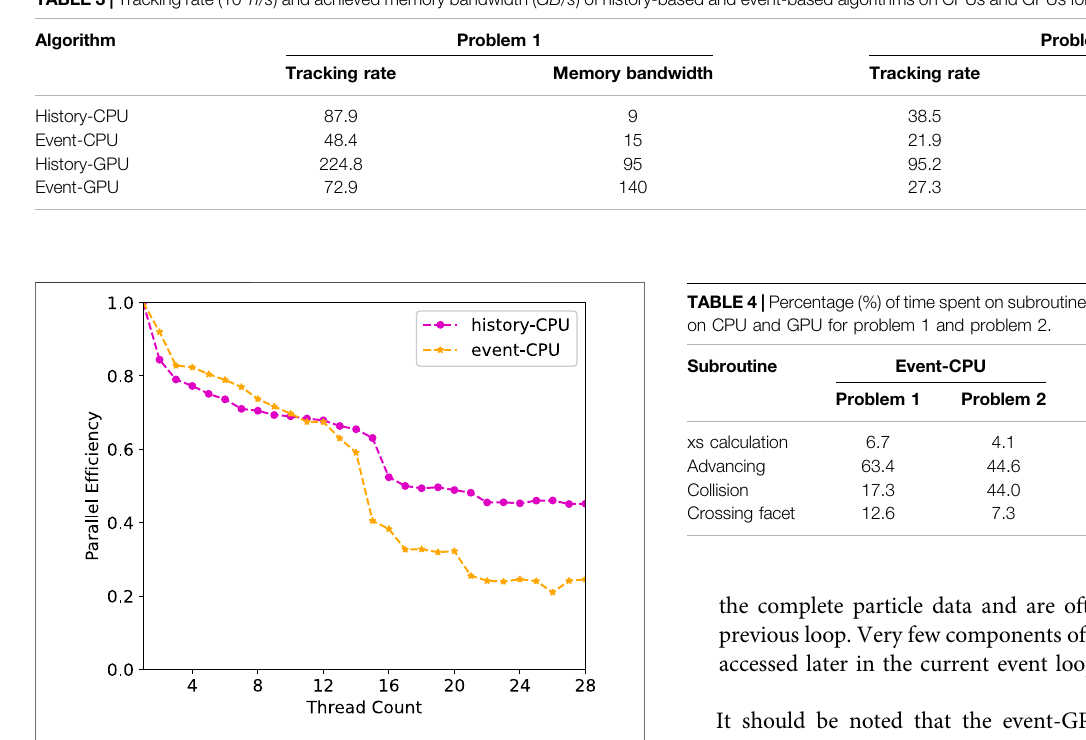
FIGURE5| Threadparallelef fi ciencyofproblem1onthetwo-socketsof Intel Xeon E5-2690 v4 14 core CPU. Only one process is used.